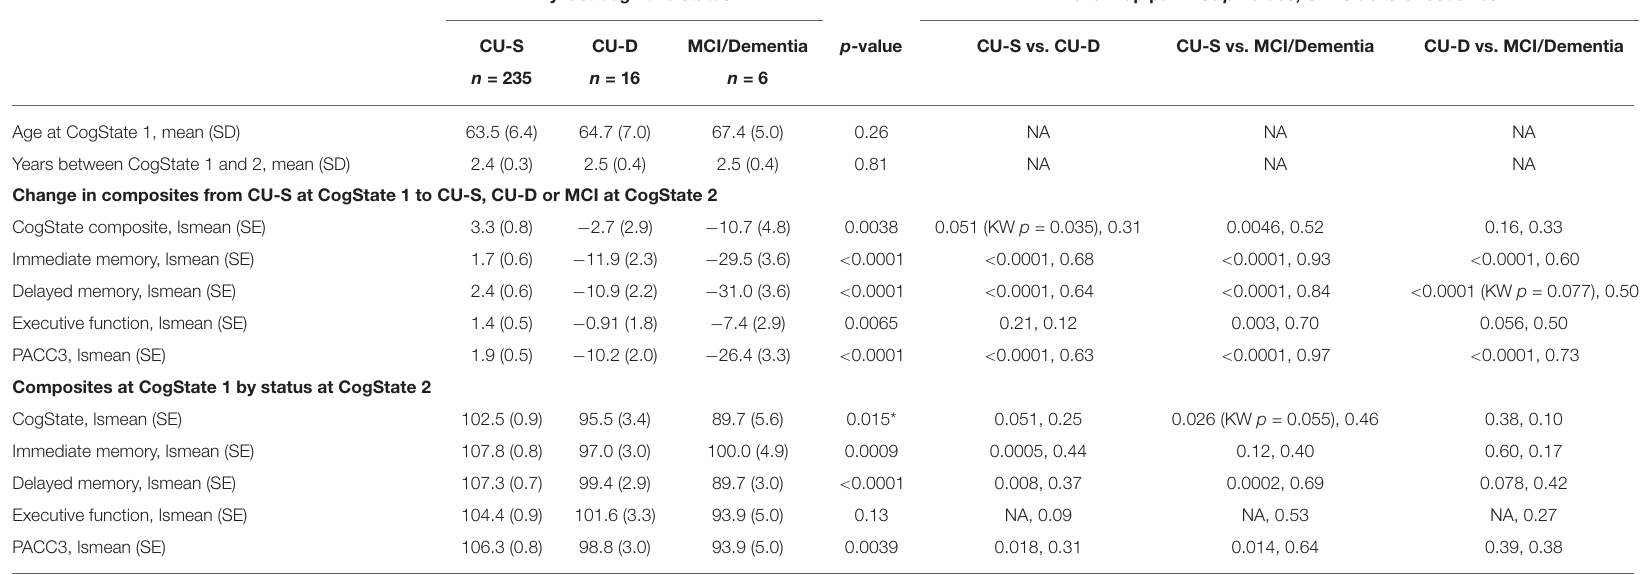
TABLE 4 | Cognitive composites and change in subset that had two CogState assessments. By last cognitive status Follow-up pairwise p -values, Cliff’s delta effect